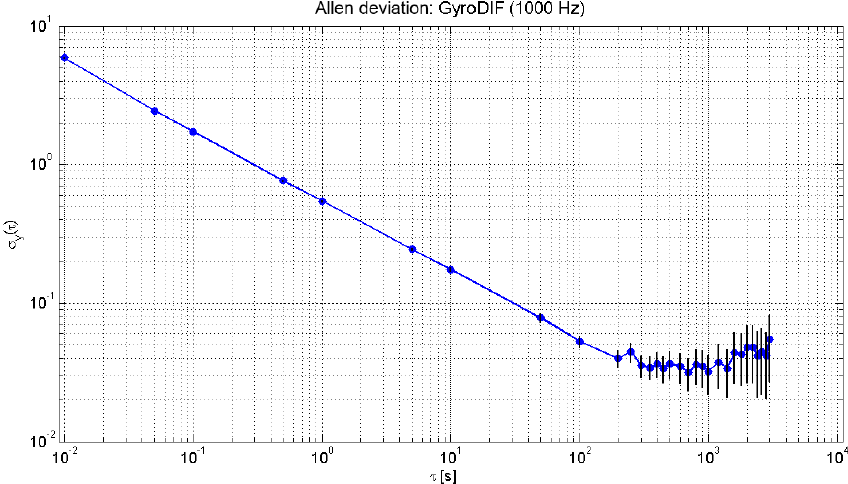
Figure 2. Allan variance plot giving the FOG output SD according to the acquisition time. The minimum value gives the bias stability and the acquisition optimum time.